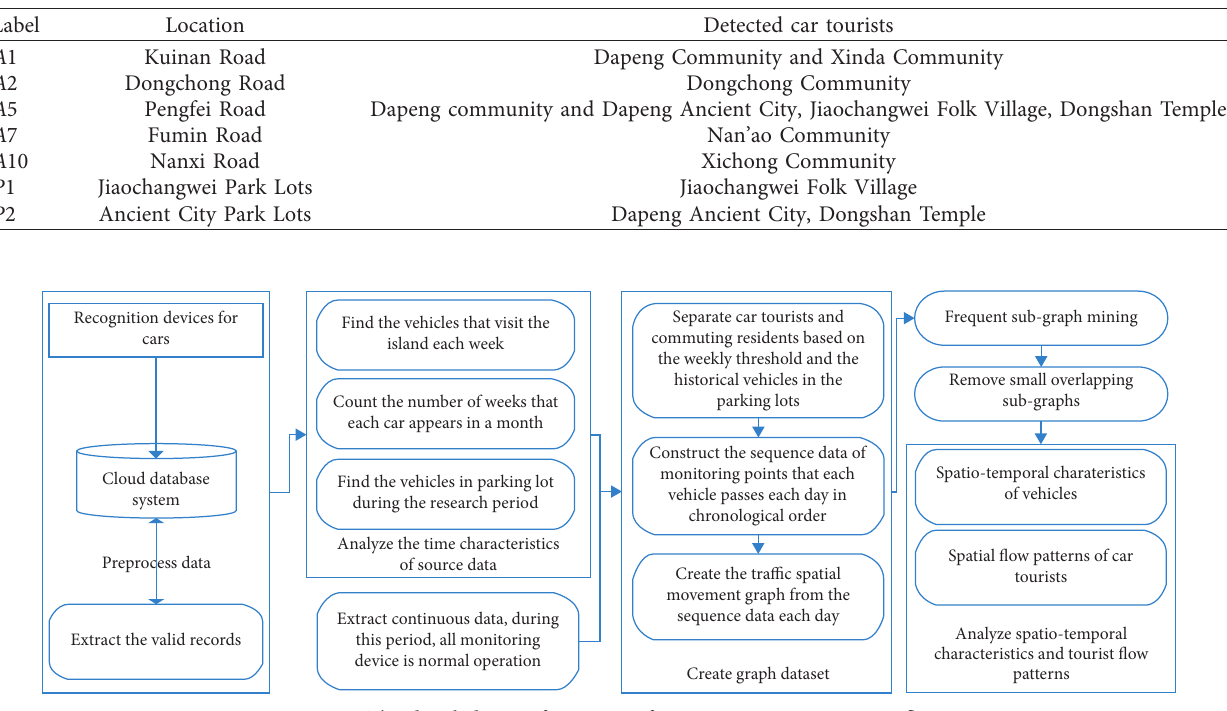
Table 1: Car tourists detected at monitoring points.